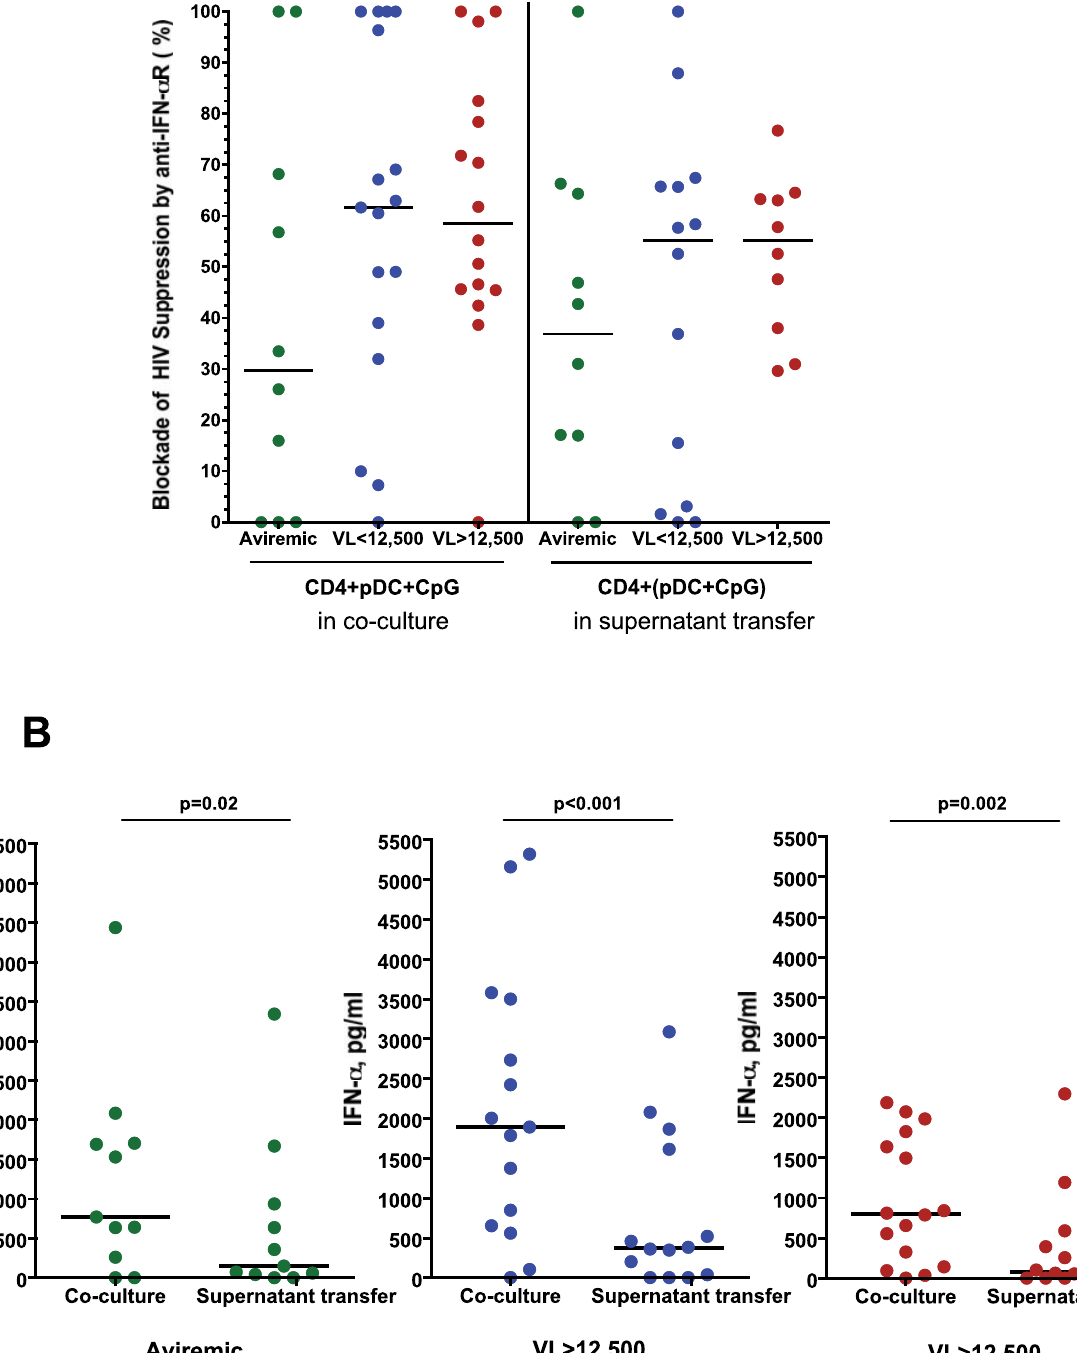
Figure 4. Interferon- a in pDC-mediated HIV suppression. A) Effect of neutralizing IFN- a receptor antibody on HIV suppression. The percent of the HIV suppression observed in co-culture experiments (left panel, data from Figure 2B) or pDC supernatant transfer experiments (right panel, data from Figure 3B) that could be neutralized by an antibody to the IFN- a receptor is indicated. No significant differences were observed between the degree of blockade of suppression between patient groups. B) Quantification of IFN- a production in pDC cultures. Culture supernatants from day 3 cultures of CD4 + T cells plus: activated pDCs (left panel of each plot, described in Figure 2) or supernatants of activated pDCs (right panel of each plot, described in Figure 3) were analyzed for IFN- a production by ELISA. Significantly more IFN- a was present in culture supernatants from CD4 + T cell- pDC co-culture experiments than in those from cultures containing pDC supernatants (p values indicated for each patient group).